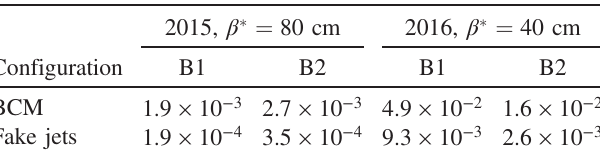
TABLE IV. Estimated background count rates in ATLAS during physics operation in Hz/bunch, calculated as the product of the average loss rates on the TCPs during standard operation (taken from the BCT measurement for the first hour in Table III) and the background counts measured per proton lost on the TCP (Table